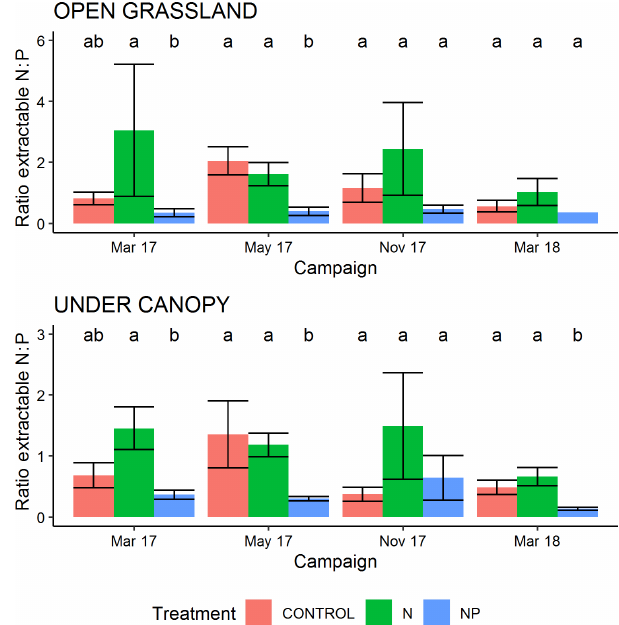
Figure 2. Ratio of extractable inorganic N (2MKCL) to extractable P (Olsen method) in 0–5cm of soil during the experiment. Over all measurements, the +N treatment has a marginally significant ( P = 0 . 06) greater N:P ratio and the +NP treatment a significantly lower ( P < 0 . 001) ratio than the control. Letters show Tukey HSD groupings within campaign–habitat combinations and error bars show the standard error of the mean.